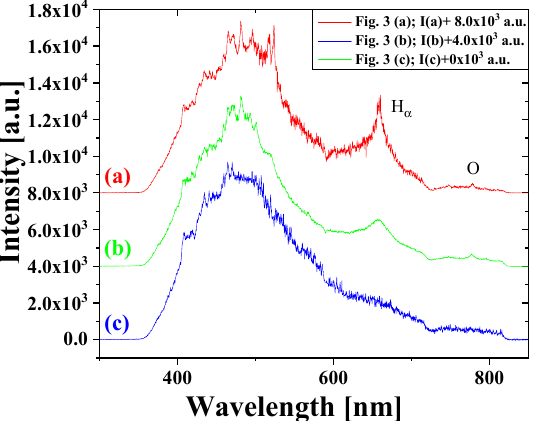
Figure 4. Optical emission spectra obtained from the discharge initiated in the different sizes of nitrogen bubble, using the optical fiber mounted in the cathode. The individual spectra are normalized (multiplied to have the same maximum value) and shifted vertically.